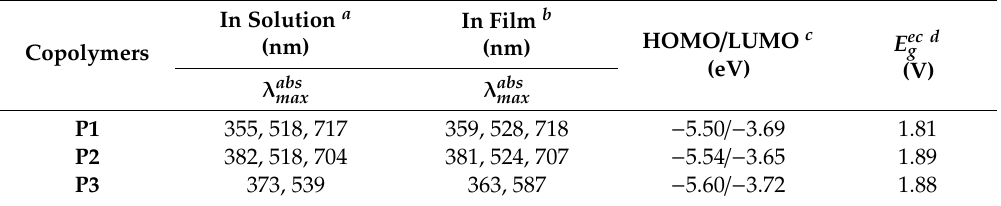
Figure 2. UV-visible absorption spectra of the copolymers in o -dichlorobenzene solutions and in thin films. Table 2. Photophysical and electrochemical properties of copolymers.